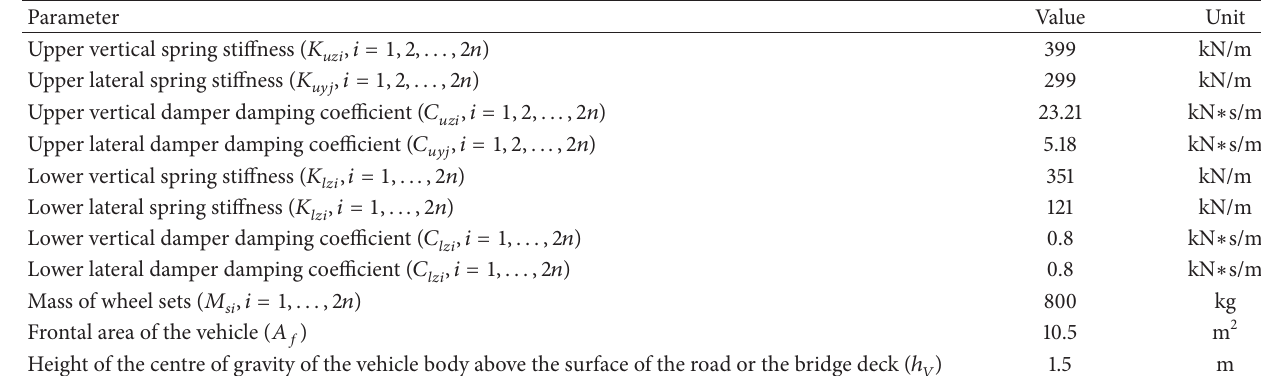
Figure 3: Dynamic models of a 4-axle vehicle: (a) cross-section view; (b) elevation view.